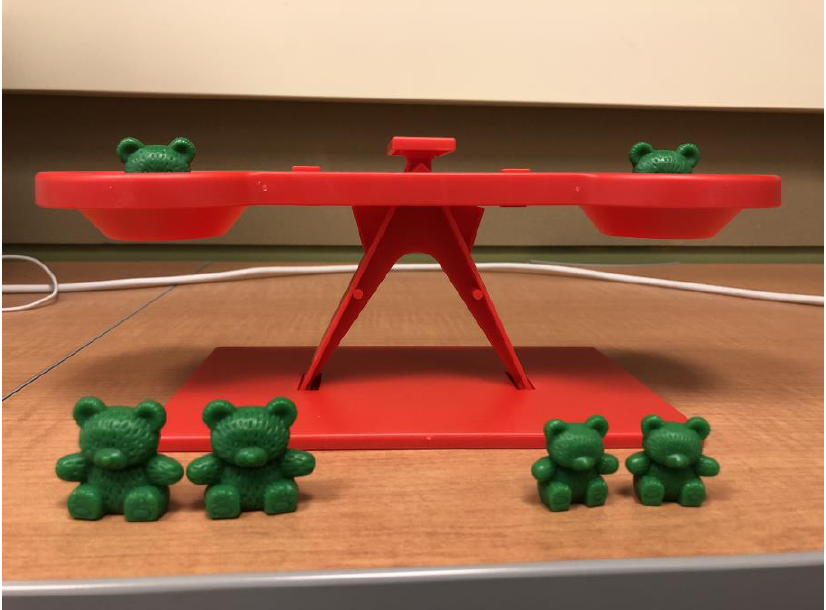
Figure 3. Image of Transfer Task.